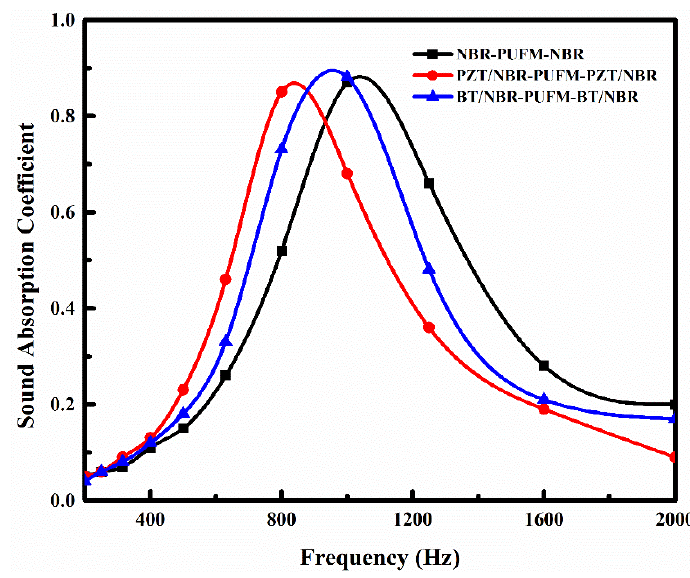
Figure 6. SAC of the sandwich structure NBR-PUFM composites after adding piezoelectric ceramics.